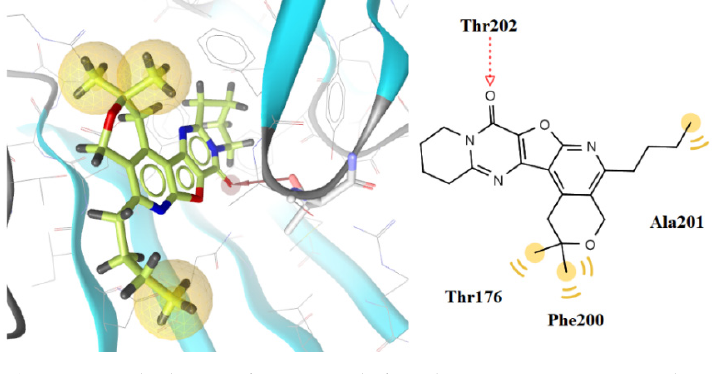
Figure 4. Docked pose of compound 6k and GABA A receptor complex; Red lines show the hydrogen bonds, yellow and purple-colored spheres and lines represent hydrophobic and aromatic interactions, respectively.